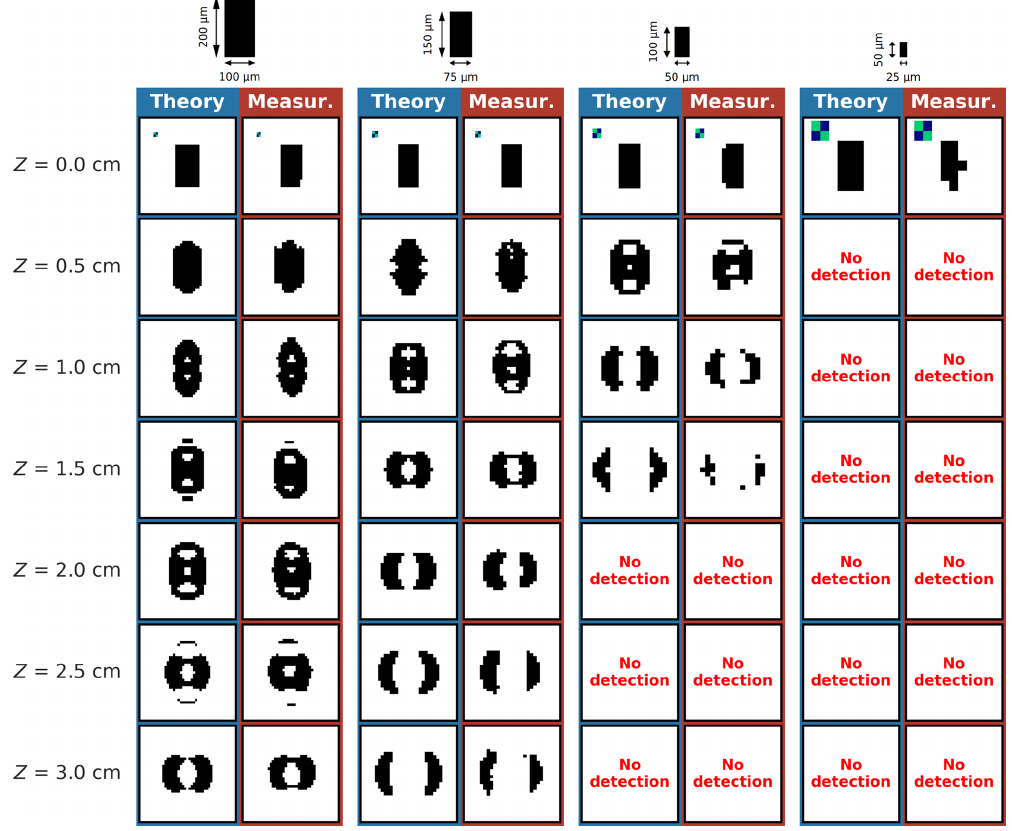
Figure 5. Theoretical and measured 2D-S diffracting patterns of 1 : 2 (width:height) opaque rectangular planar shape particles (short columns) at several distances Z from the object plane. Images are framed according to the particle size; the blue and green target in the first line shows the 2 × 2-pixel scale for the images in the entire column